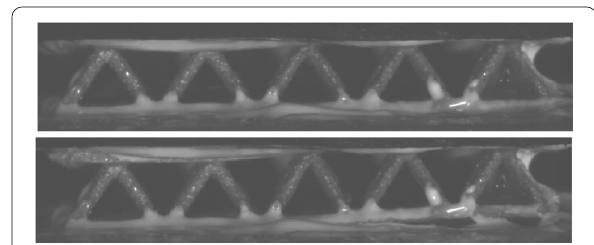
Figure 15 Pictures of one speciment during testing (Top: before load drop, Bottom: after load